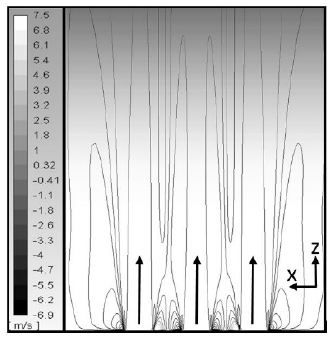
Figure 12. Radial velocity contours in the centerline plane.